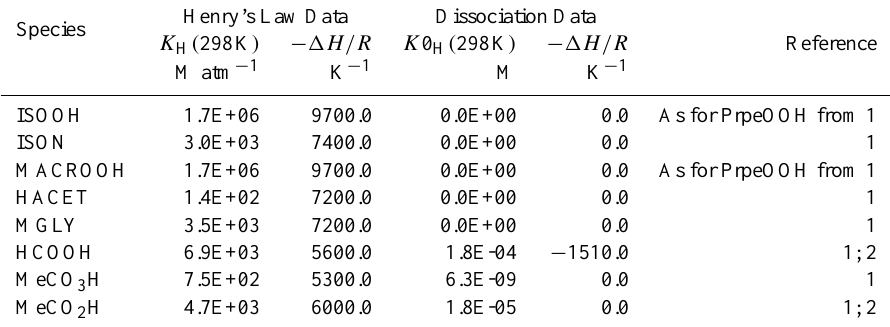
Table 2. Values required to calculate the effective Henry’s Law coefficient for the additional soluble species included in the UKCA stan- dard tropospheric scheme with isoprene oxidation (TropIsop), where Me = CH 3 , IS = C 5 H 7 , ISON = lumped peroxy alkyl nitrates (from C 5 H 8 + NO 3 ) and hydroxy alkyl nitrates (from ISO 2 + NO), MACR = lumped species consisting of methacrolein, methyl vinyl ketone and other C 4 carbonyls from isoprene oxidation, HACET = hydroxyacetone and other C 3 ketones, MGLY = methylglyoxal and other C